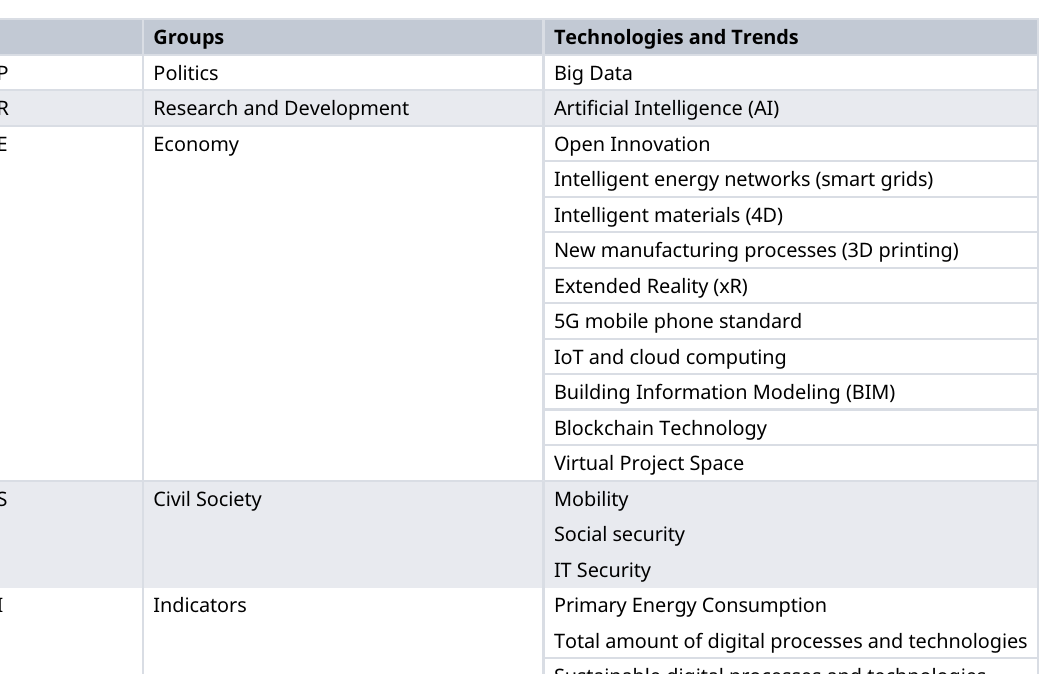
Table 7. Groups of stakeholders and indicators with assigned technologies and trends according to Goger et al., 22 Digital Roadmap Austria 30 and BRZ.